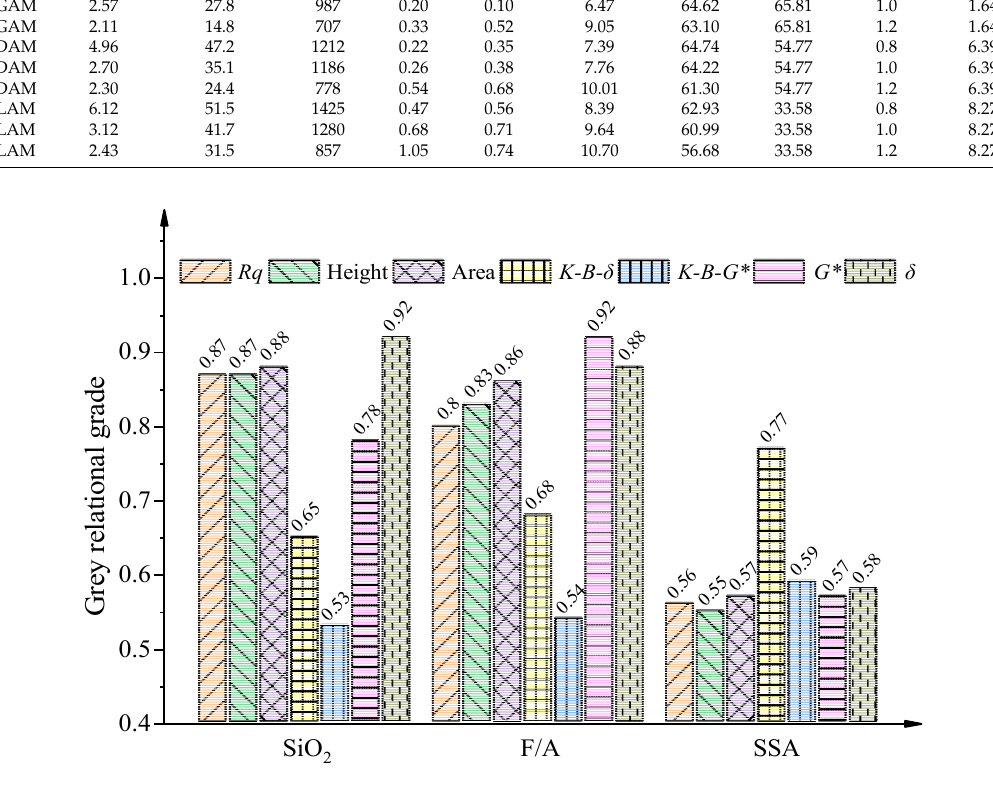
Figure 12. Grey relational grade.